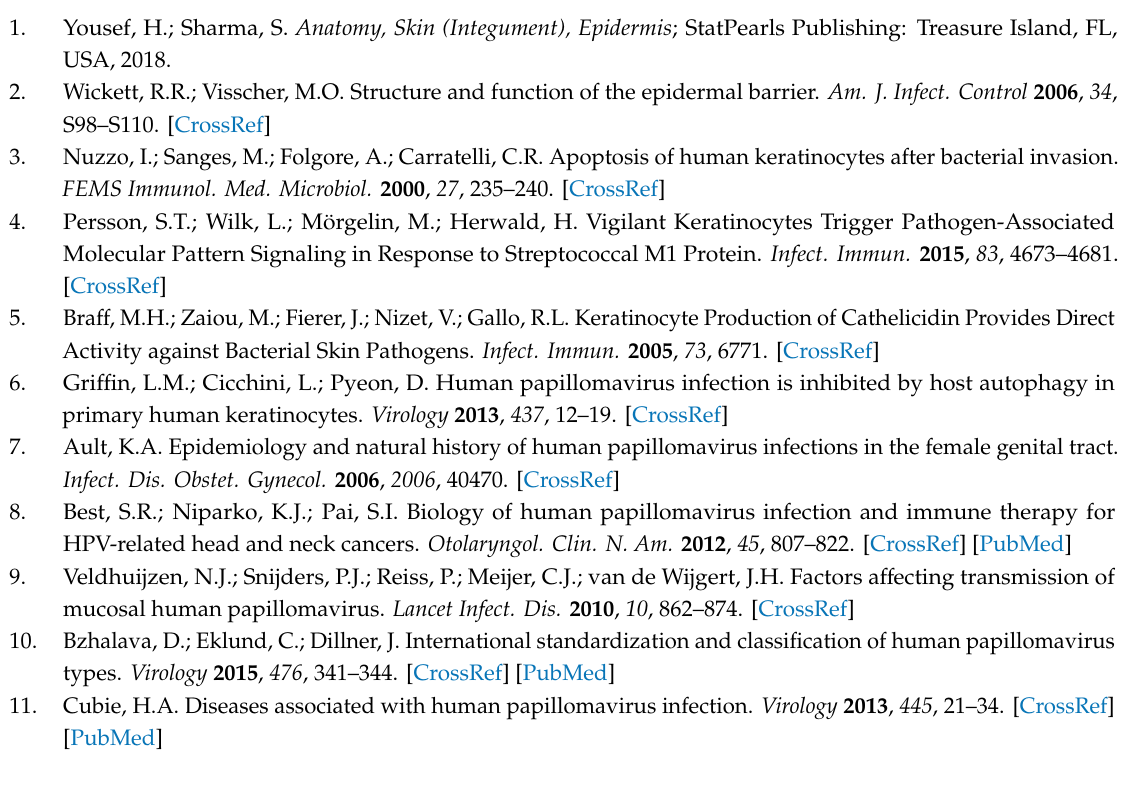
Figure S1: Fold change for the six di ff erentially expressed miRNAs in each wart (W) and control (C) sample, Table S1: Predicted disease associations of the candidate